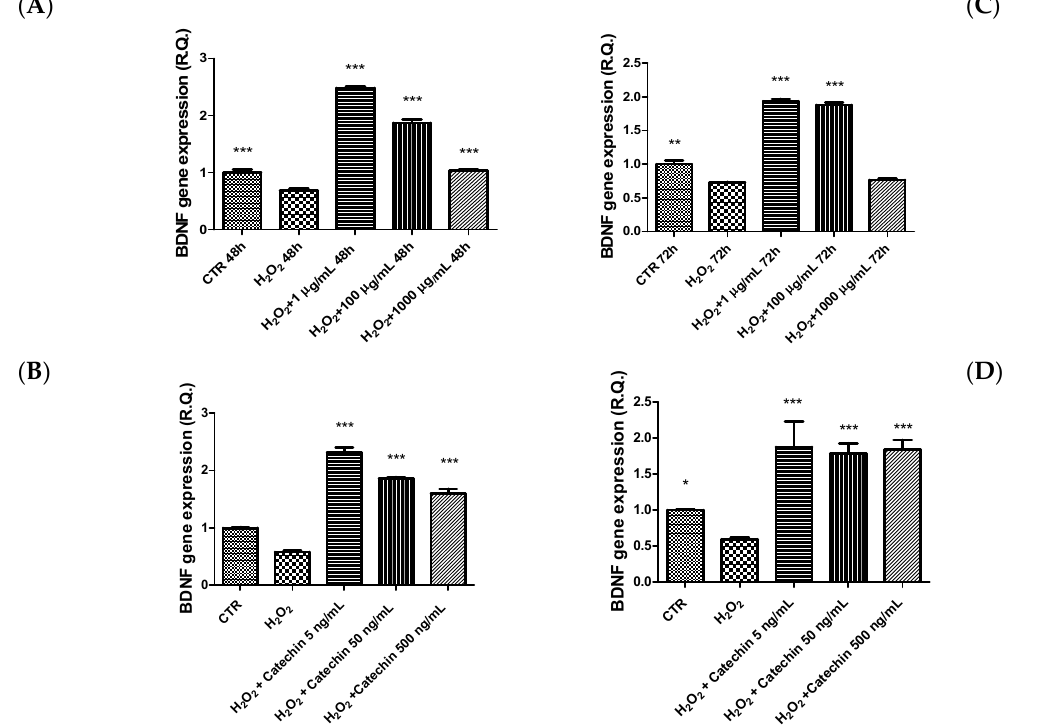
Figure 7. Inhibitory effects exerted by grape pomace water extract (1–1000 µg/mL) and catechin (5–500 ng/mL) on hydrogen peroxide (H 2 O 2 )-induced decrease in brain-derived neurotrophic factor (BDNF) gene expression in HypoE22 cells. The efficacy of the extract was evaluated at different time points: 48 h ( A , B ); 72 h ( C , D ). ANOVA, p < 0.0001; * p < 0.05, ** p < 0.01, *** p < 0.001 vs. respective hydrogen peroxide group (H 2 O 2 ) .